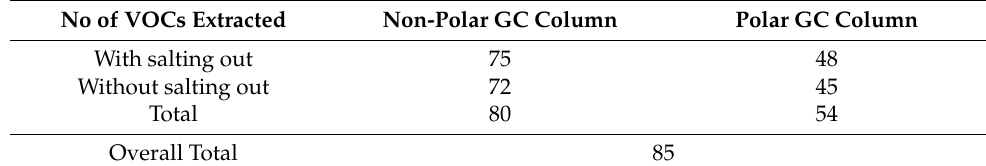
Table 3. The numbers of volatile organic compounds extracted in whole milk powder samples.